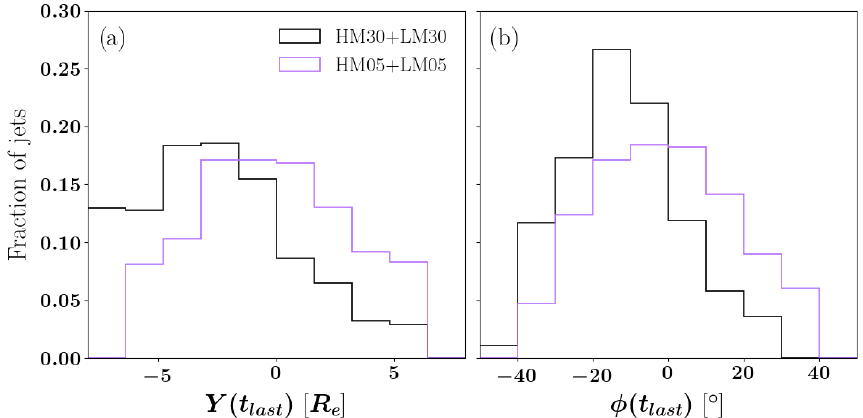
Figure 12. Jet end position within the magnetosheath in terms of (a) the y coordinate and (b) (cid:56) = arctan (y/x) , where [ x, y ] are the last coordinates of the jet when it was still detected. The black line gives the jets for the runs with a 30 ◦ cone angle, while the purple lines are the results for the 5 ◦ cone